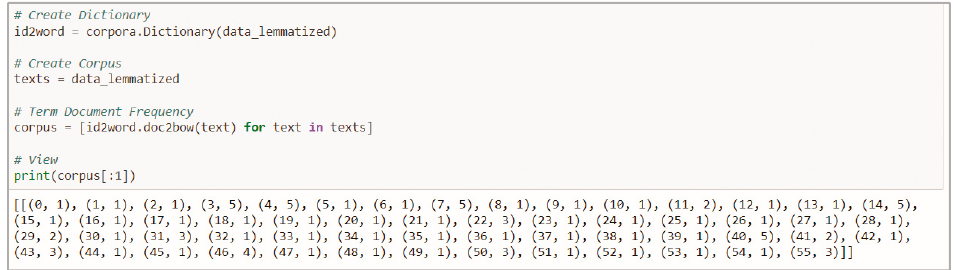
Figure 4. Code 2: Recognizing main topics, own elaboration.